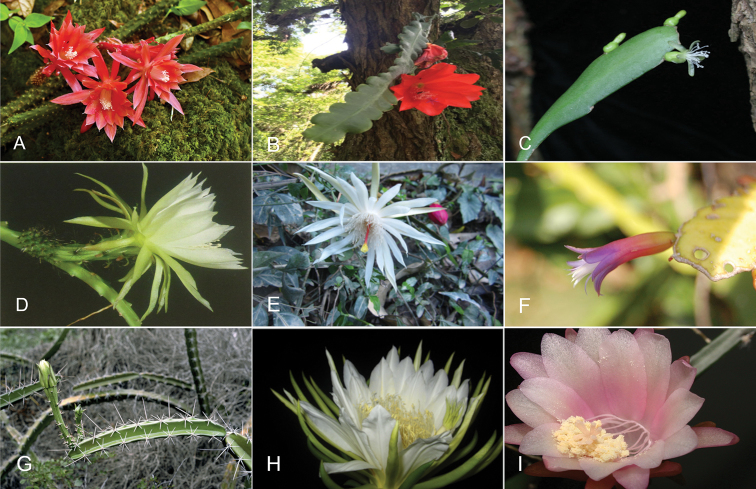
Morphological variation in tribe Hylocereeae. AAporocactus
martianus (Photo S. Avendaño) BDisocacus
ackermannii (Photo C. Ruiz) CKimnachia
ramulosa
subsp.
ramulosa (From Flora de Nicaragua, O.M. Montiel) DSelenicereus
atropilosus (From Hunt 2006) EEpiphyllum
hookeri (Photo C. Ruiz) FPseudorhipsalis
amazonica (From Mobot - Hammel 24524) GAcanthocereus
tetragonus (Photo C. Gómez-Hinostrosa) HSelenicereus (Hylocereus) undatus (Photo C. Ruiz) IWeberocereus
tunilla (From Mobot – B. Hammel 22442).